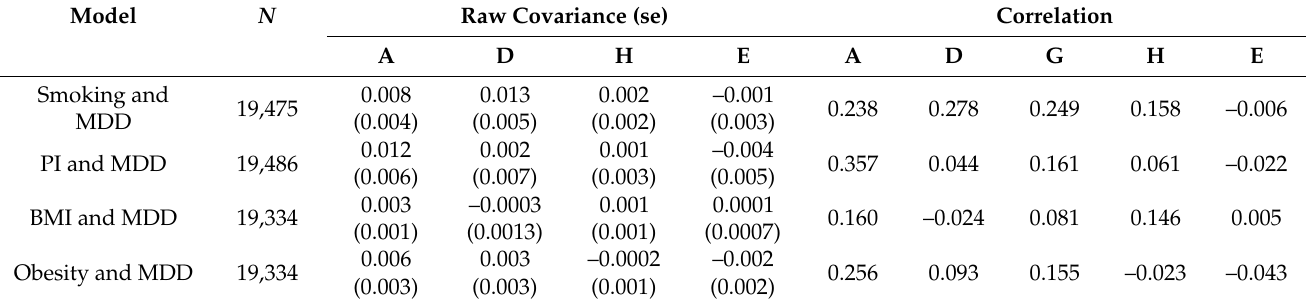
Table 5. Maximum-likelihood (co)variance component estimates and derived correlation estimates between major depres- sive disorder and four lifestyle factors: smoking behavior, physical inactivity, body-mass index, and obesity. All models included sex, age, and age 2 as fixed covariates. MDD = major depressive disorder; PI = physical inactivity; BMI = body-mass index; VC = variance component; se = standard error; A = additive genetic component; D = non-additive genetic component; H = household component; E = unique environment component; G = genetic component, where A + D = G. Model N Raw Covariance (se) Smoking and MDD PI and